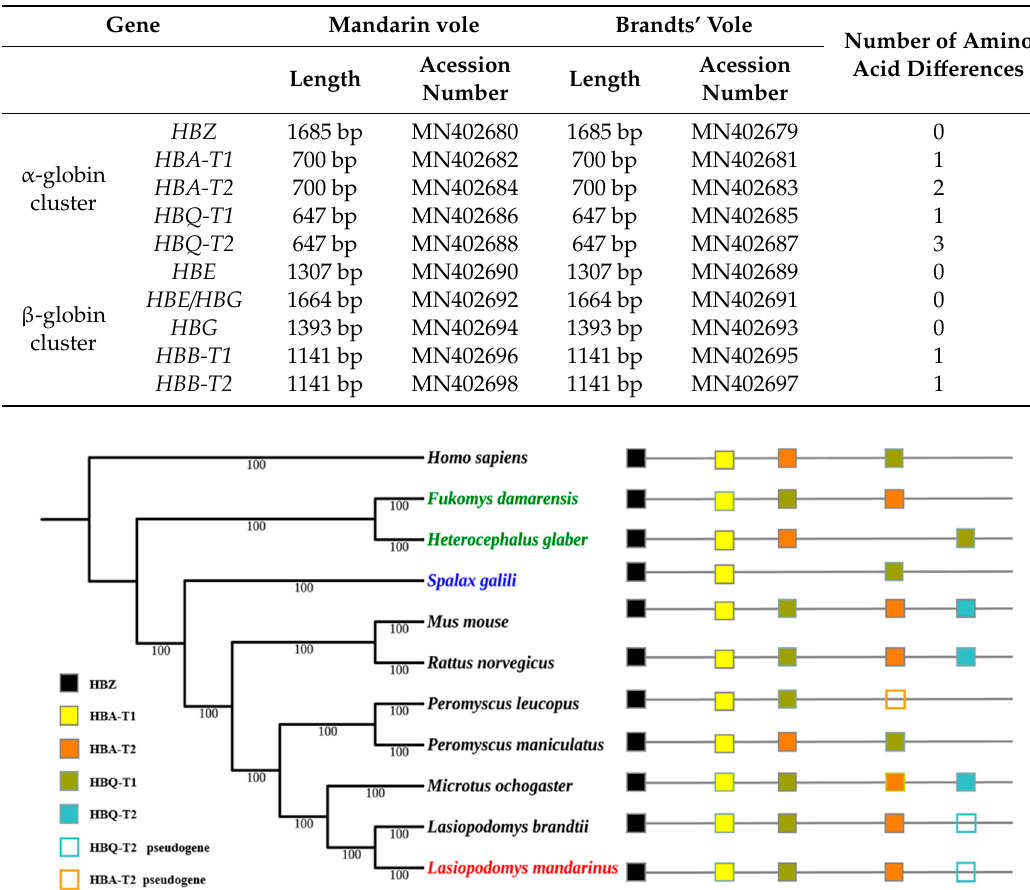
Figure 3. Bayesian phylogenetic tree of rodent species and the genomic structures of their β -globin genes. Numerals indicate Bayesian posterior probability values; colored text indicates subterranean rodent species. 2.3. Selection Pressure Analysis Branch models were used to calculate the ω -value of α - and β -globin genes; the estimated ω ratio of the α - and β -globin genes was <1, indicating that most Hb genes had undergone purifying selection (Supplementary Table S1). To investigate whether there are restricted positive selection sites in some specific lineages, positive selection sites were identified using the branch-site model for Hb genes (Table 2). Significant positive selection sites were found in HBA-T1 of the S . galili lineage (12K - 0.999 *; p = 0.001) and the naked mole-rat branch (2V - 0.975 *, 21H - 0.957 *, 87L - 0.964 *, 89A - 0.981 *, 105C - 0.965 *, 124A - 0.971 *, and 134S - 0.978 *), but likelihood-ratio test (LRT) results were not significant ( p = 0.746). Positive selection sites were also identified in HBB-T1 of the S . galili lineage (17G - 0.966 *, 87A - 0.995 **, and 113C - 0.960 *; p < 0.001), naked mole-rat lineage (24V - 0.981 *, 109N - 0.929 *, 140A - 0.984 *, and 143A - 0.941 *; p < 0.001), and Damaraland mole-rat lineage (23E - 0.952 *, 56M - 0.992 **, 57G - 0.990 *, 70G - 0.967 *, 75G - 0.953 *, 110V - 0.983 *, 114V - 0.987 *, and 121K - 0.955 *; p < 0.001). However, no significant positive selection sites were identified in the other tested genes among different subterranean rodent branches.